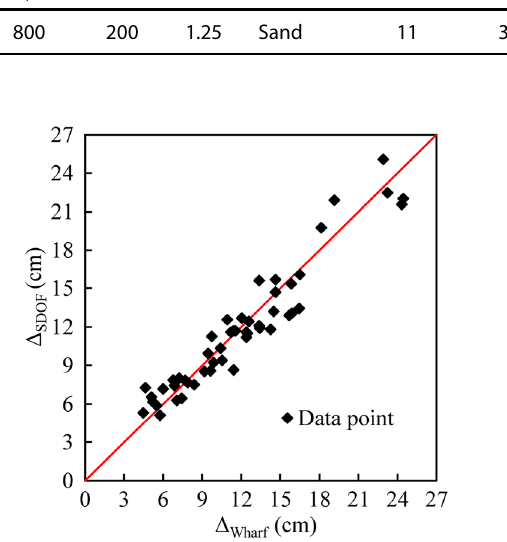
Table 2 Properties of piles and dike soil for case study I